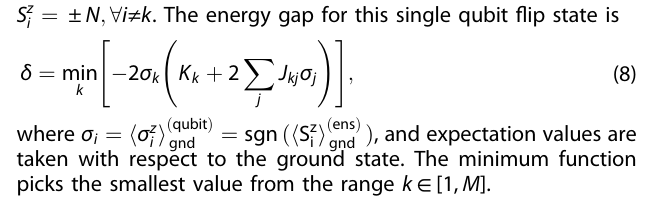
Fig. 2 Energy spectrum and gap energies of the adiabatic quantum computing Hamiltonian. The spectrum of Eq. (3) with M = 3 with ( a ) N = 1 and ( b ) N = 5 for parameters J 12 = − 0.5, J 13 = 0, J 23 = − 1, K 1 = 0.5, K 2 = 0, K 3 = 1. The mean- fi eld approximation for the N = 5 is shown as the dashed lines for the ground and fi rst excited state. c The gap energy for the ensemble qubit numbers is shown. d Scaling of the gap energy with N for two values of λ as shown. The mean- fi eld (MF) approximation is shown as the dotted line in c and d . e The minimum gap vs. N for 60 random instances of problems with N c = 3. The average minimum gap, as well as the largest (best) and smallest (worst) instances, are shown. f Same as e for problems with N c >